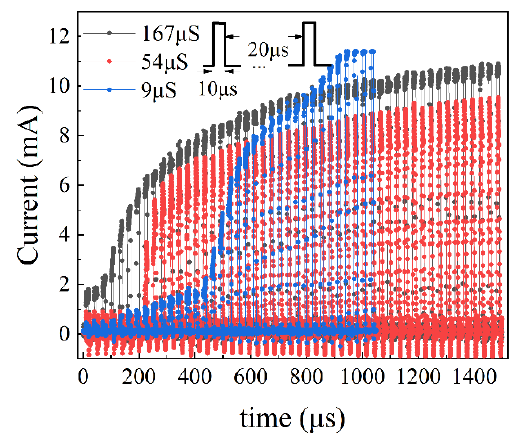
Figure 5. Dynamic current response typical of varying initial conductance and a fixed 0.6 V amplitude, 10 µ s pulse width, and square-waveform voltage pulse (rise time = 500 ns). The reset stop voltages are −0.9 V (black), −1.0 V (red), and −1.1 V (blue). The curve represents the current flowing through the device and not its conductivity state.